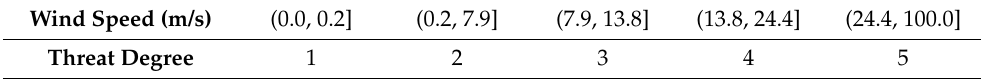
Figure 3. Sketch map of weather station and its actual remote sensing map. ( a ) Sketch map of weather station. ( b ) Actual remote sensing map which comes from Google earth (https://www.google.com/earth/ accessed on 19 January 2020). Table 2. Definitions of wind speeds and their threat